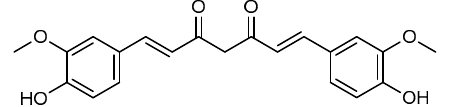
Figure 1. General structure of diarylpentanoids.